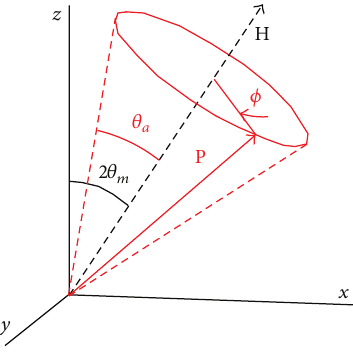
Figure 5: Graphic representation of neutrino oscillations. Neutrino polarization vector P precesses around the Hamiltonian vector H (or the vector of eigenstates of the Hamiltonian). The angle between P and H is given by the cone angle 𝜃 𝑎 , and the direction of axis of the cone is determined by the mixing angle in matter 2𝜃 𝑚